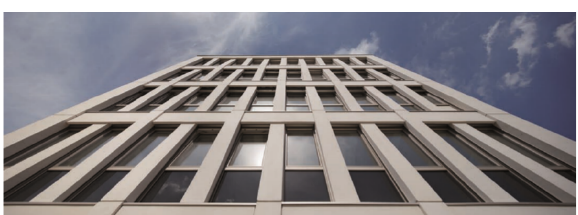
Figure 1. Precast concrete sandwich panels for use as a façade